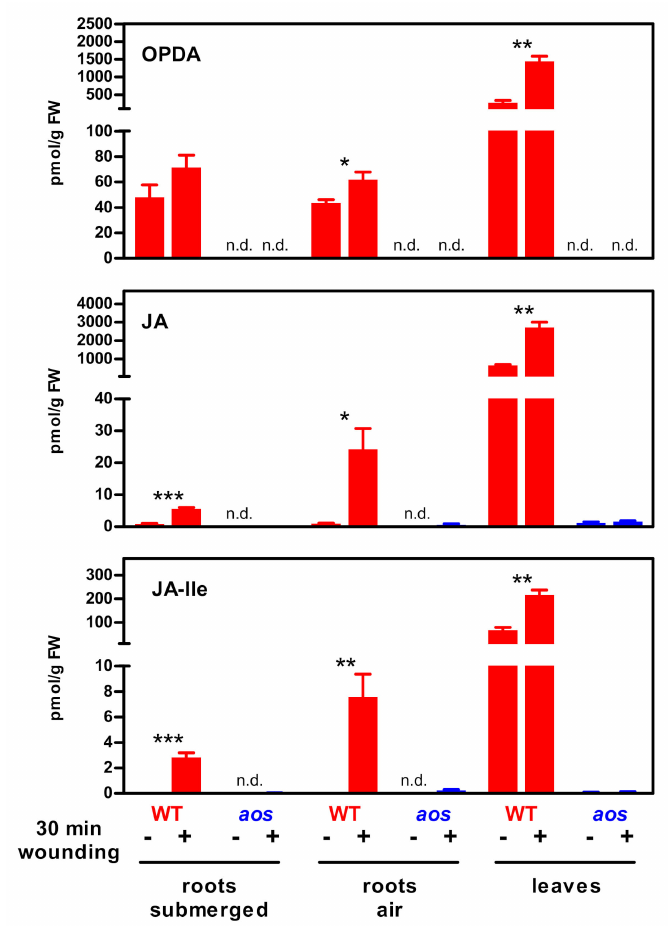
Figure 2. OPDA, JA and JA-Ile levels in roots and leaves of wild-type and aos plants, 30 min after wounding ( + ) or control treatment ( − ). Roots were either incubated in hydroponic solution (submerged, same samples as shown in Figure 1) or air (pseudo-aeroponic). Data are mean values ± SEM from four (wild-type roots) or three (wild-type leaves and aos roots and leaves) samples, each obtained from two pooled individual plants. Asterisks denote statistical significance between control and treated samples (unpaired, two-tailed t -test. * p < 0.05; ** p < 0.01; *** p < 0.001). n.d.; not